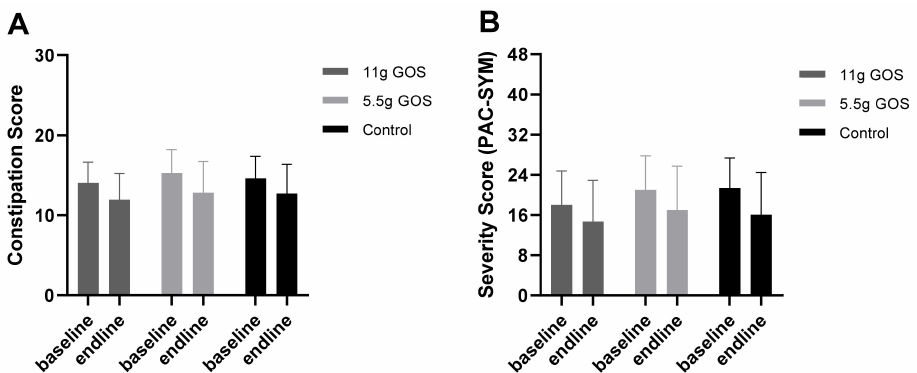
Figure 3. ( A ) Constipation score (based on Agachan et al., 1997) (ranging from 0–30) and ( B ) symptom severity score (PAC-SYM) (ranging from 0–48) of ITT population at baseline and after the intervention period. The ANCOVA did not show any differences in Constipation Score between 11 g GOS and control ( p = 0.529), nor between 5.5 g GOS and control ( p = 0.717). The ANCOVA did not show any differences in PAC-SYM scores between 11 g GOS and control ( p = 0.801), nor between 5.5 g GOS and control ( p =